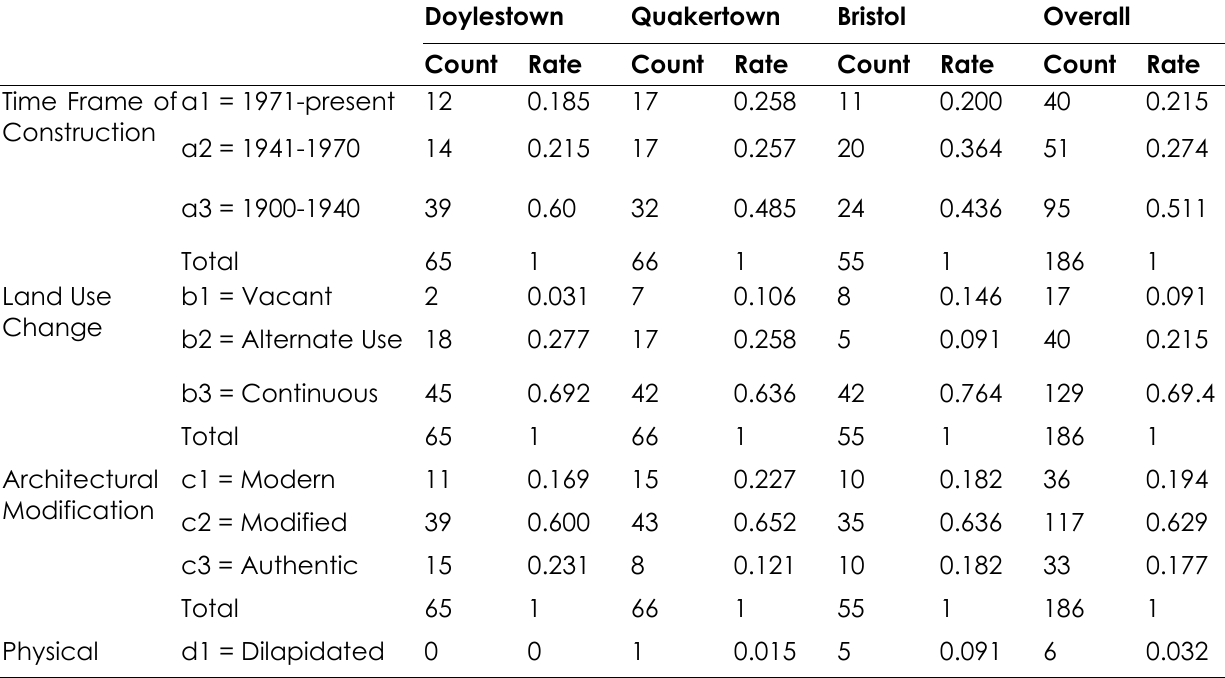
Table 2. Inventory of measures accepted for structures sampled per